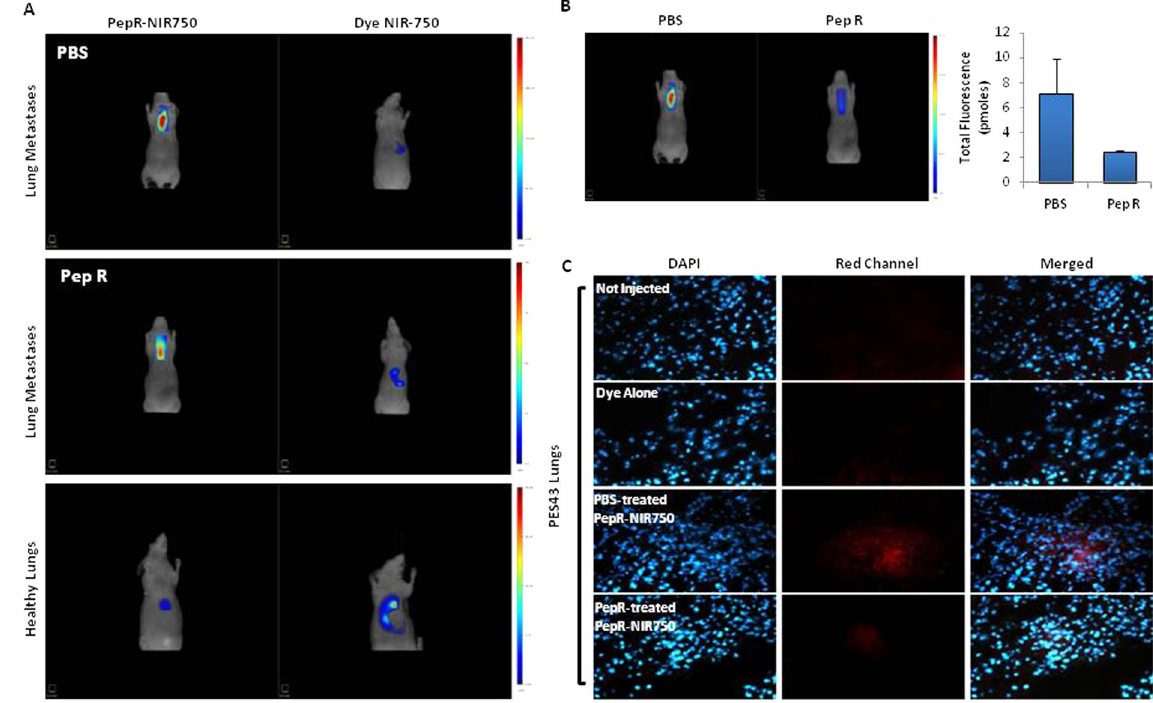
Figure 6. PepR-NIR750 detects lung metastases reduction induced by Peptide R treatment. CD-1 nu/nu athymic mice bearing PES43-derived lung metastases were treated with PBS (control group) or Peptide R (2 mg/ Kg) 5 days/week for 2 weeks. 3 weeks later mice were i . v . injected with PepR-NIR750 or VivoTag-S 750 alone and total body imaged after 24 h with FMT4000. ( A ) PepR-NIR750 signal is detectable in mice bearing lung metastases (upper and middle left panels) while no signal was revealed with VivoTag-S 750 alone (upper and middle right panels). Healthy lungs are not imaged by PepR-NIR750 (lower panel). ( B ) In vivo imaging of mice bearing lung metastases treated and not treated with Peptide R using Pep-R-NIR750. Peptide R causes a strong reduction of PepR-NIR750 signal (65%) respect to control group as observed 24 hours after its injection. ( C ) After 24 h the mice were euthanized, the lungs snap frozen and then were 5 µ m sliced at cryostat microtome. Slides of PepR-NIR750 or VivoTag-S 750 were imaged at fluorescence microscope Axioscope